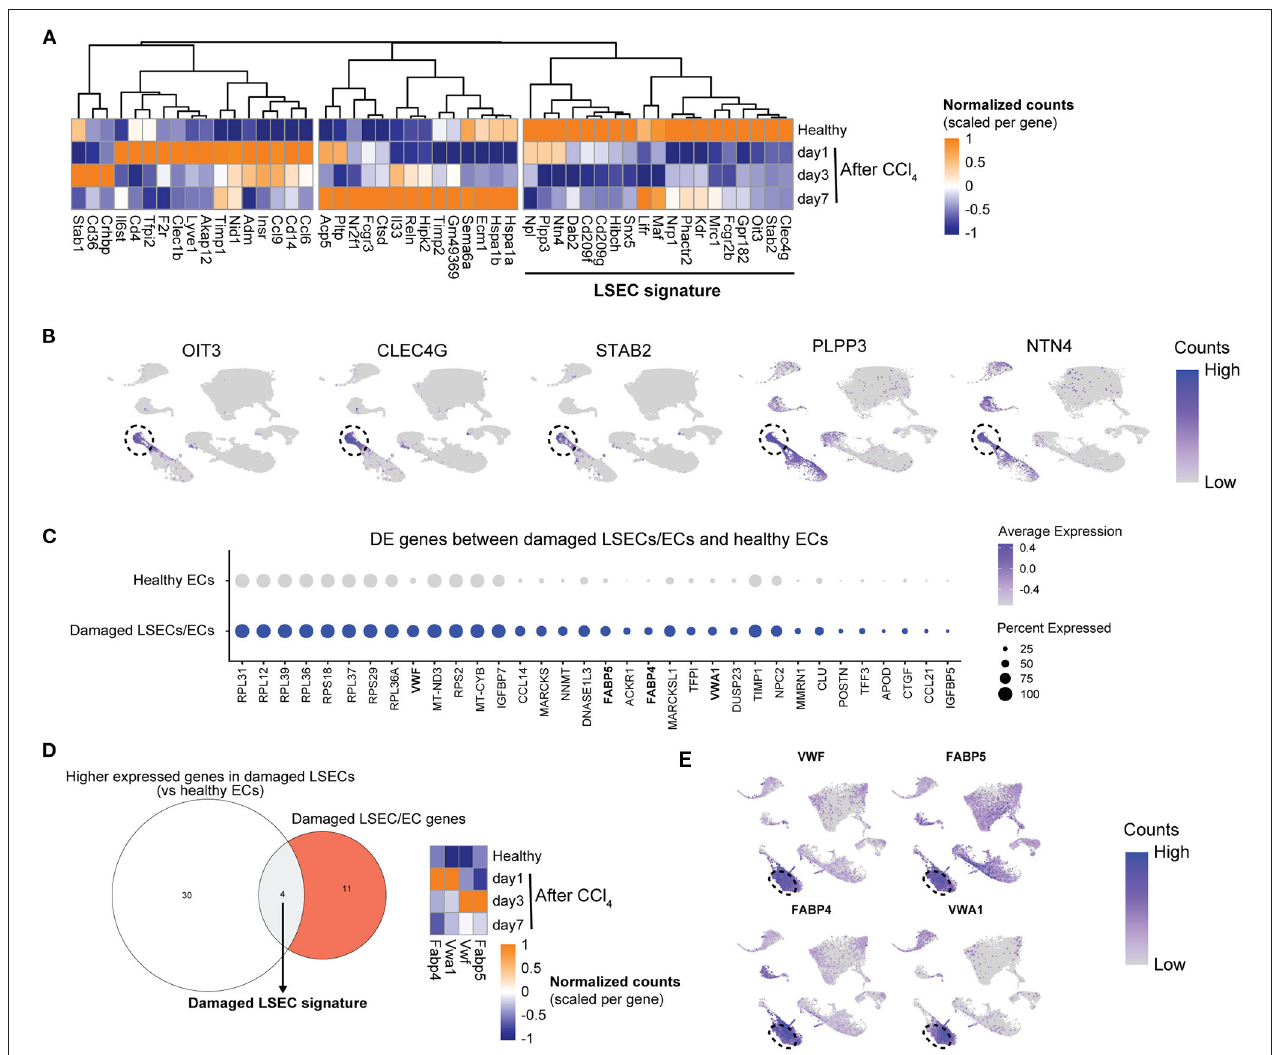
FIGURE 5 | Development of an LSEC and a damaged LSEC gene signature. (A) Heatmap of the enriched healthy human LSEC genes in LSECs from healthy and acutely injured mouse livers. The genes used for the LSEC signature are underlined. (B) UMAP plot of Ramachandran et al. ( 25) dataset with gene expressions in healthy livers for LSEC signature genes with the LSEC population marked by the dotted line. (C) Dot plot of differentially expressed genes between damaged LSEC/EC population and healthy ECs from Ramachandran et al. (25). (D) Venn diagram of genes higher expressed in damaged LSECs from (C) and damaged LSEC/EC signature. The damaged LSEC signature is represented by the overlapping region. Heatmap of LSEC signature genes in LSEC from healthy and acutely injured livers. (E) UMAP plot of Ramachandran et al. (25) dataset with gene expression from damaged LSEC signature genes in cirrhotic livers. Damaged LSEC population is marked by the dotted